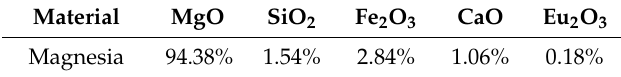
Table 1. Chemical compositions of the solid magnesia powder.